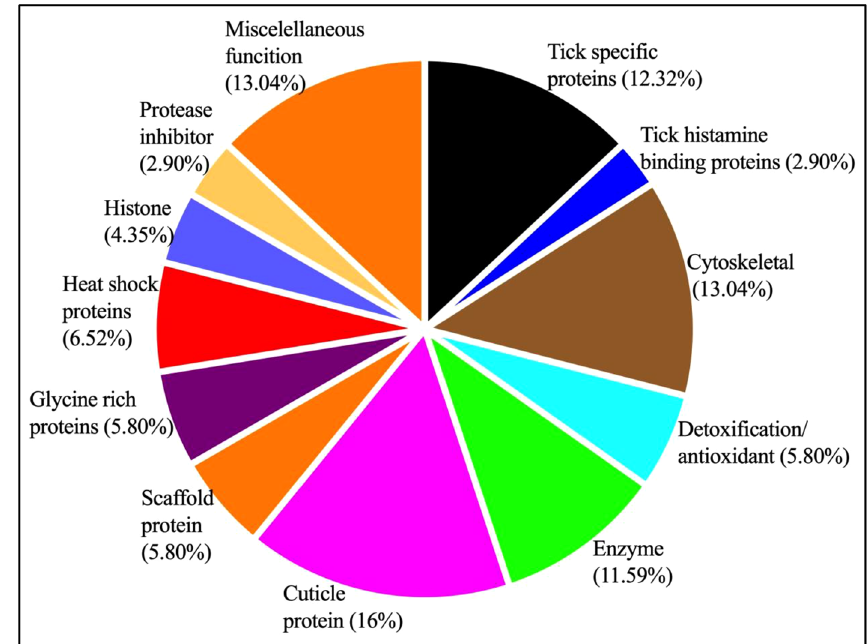
Figure 3. Protein functional categories in the inner core layer of I. scapularis tick attachment cement. Functional categories were determined based on matches to annotated proteins and conserved domain databases as summarized in supplemental Table 1C. Total protein counts in each functional category were plotted in PRISM